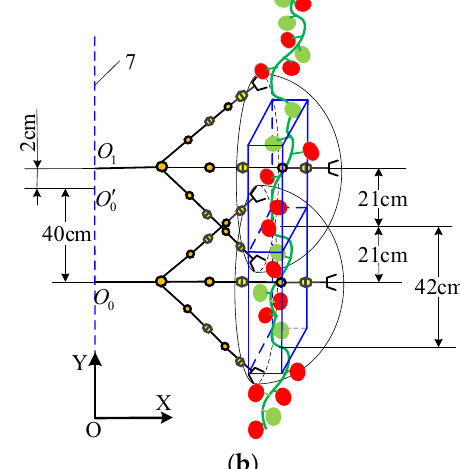
Figure 4. Schematic diagram of the intermittent mobile operation of the robotic pick. 1: chassis operation docking point; 2: chassis cruise path; 3: tomato plant planting line; 4: the picking robot’s traveling ridge; 5: tomato-picking robot; 6: arch bracket.